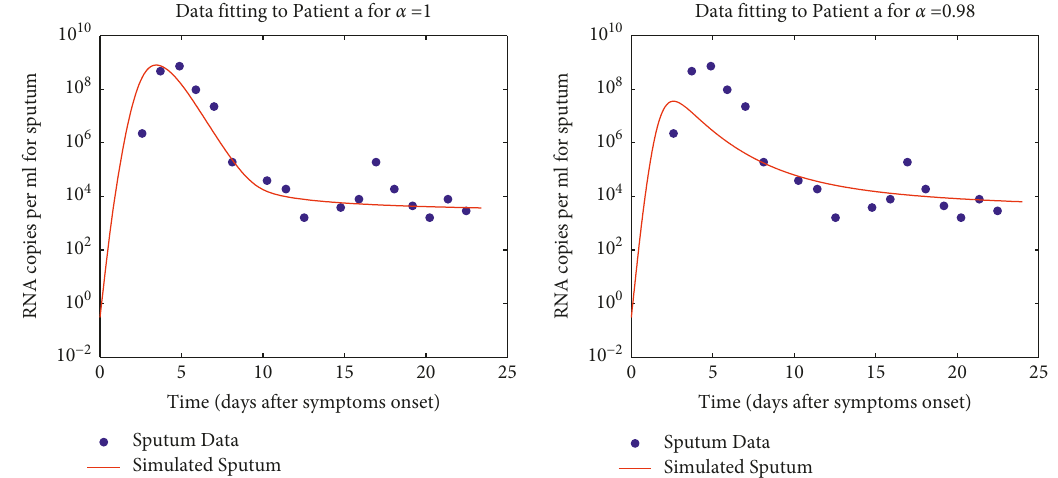
Figure 1: Data fitting for patient a .